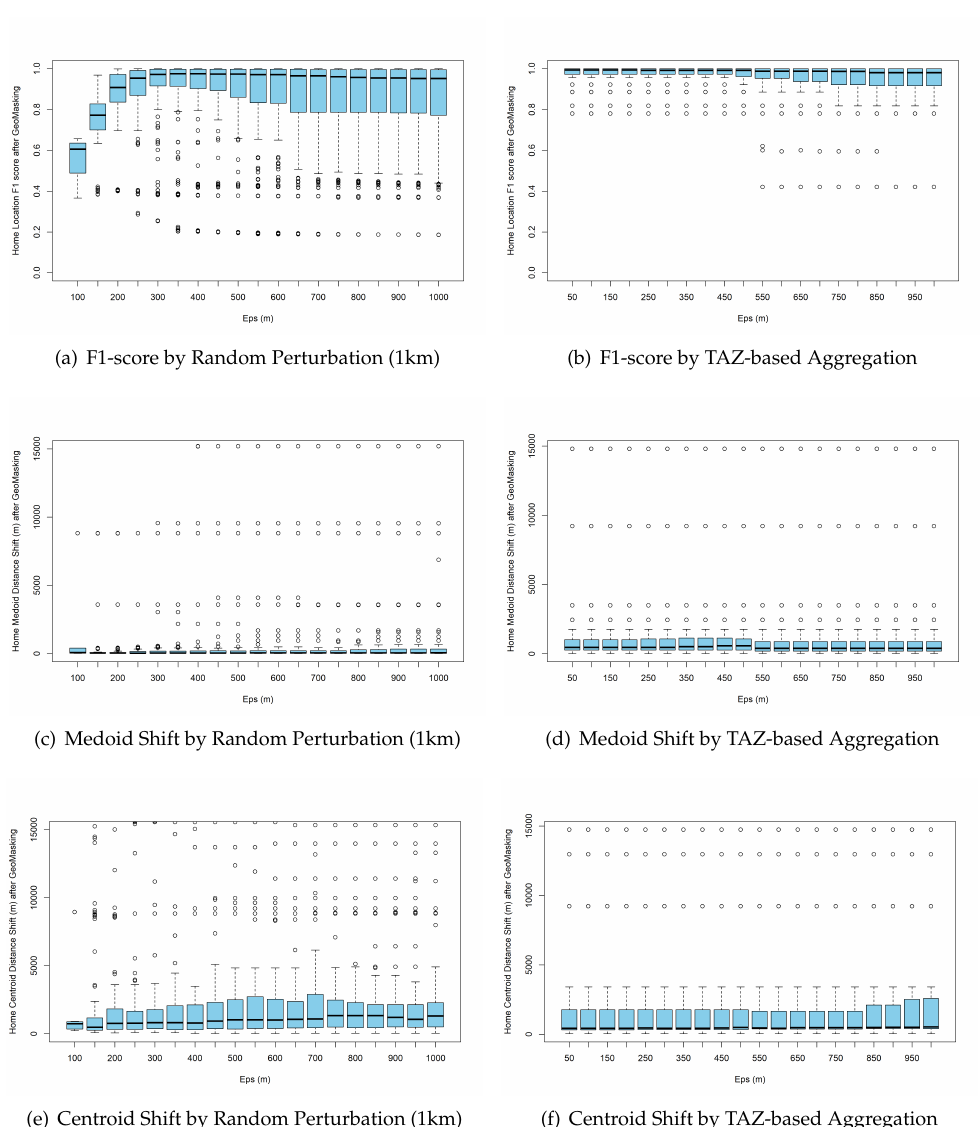
Figure 5: The boxplot of F1-score, medoid and centroid distance shifts of home cluster de- tection with different DBSCAN parameters with random perturbation and the TAZ-based